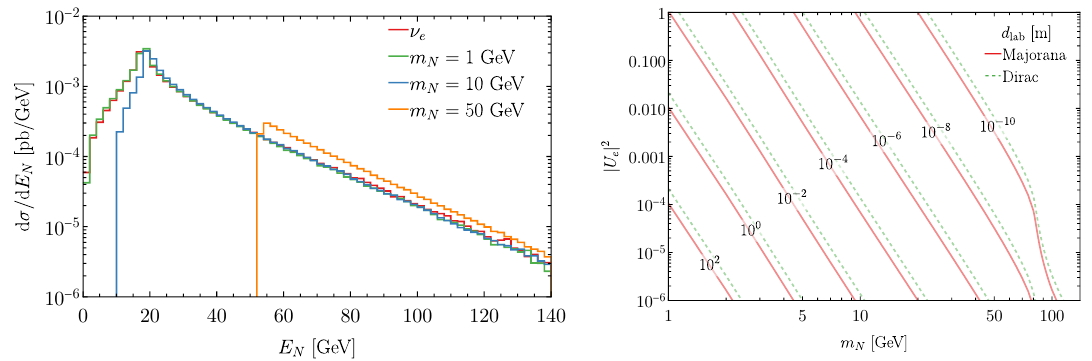
Figure 10 . Left: the energy distribution of N ( ν e ) in the production channel ep → jN ( ν e ) at the EIC with beam energy as E p × E e = 275 × 18 GeV 2 . Right: the typical decay length of HNL in the EIC lab frame estimated with the condition E N ∼